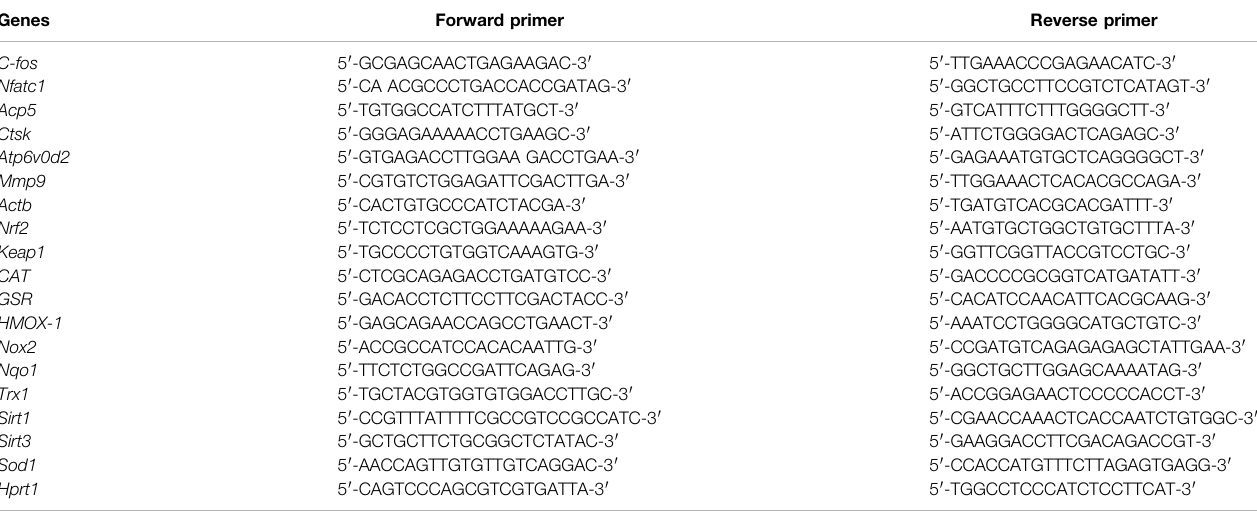
TABLE 1 | Primers for qRT-PCR assay.